Question: Express in one sentence what the figure is showing.
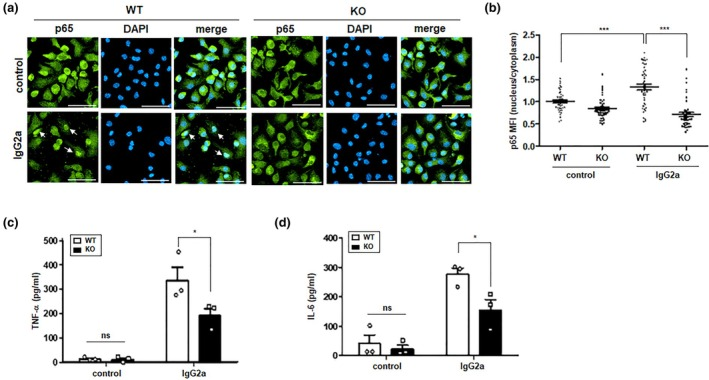
Answer: Impaired FcγR‐mediated NF‐κB nuclear translocation and cytokine production in ARAP‐KO BMDCs. (a, b) WT and KO BMDCs (2 × 10 5 ) either alone or with IgG2a and antimouse IgG antibody were added to the coverslips and incubated at 37°C for 1 h. For an immunofluorescence assay of NF‐κB (p65), cells were fixed, permeabilized, and stained with anti‐p65 followed by FITC‐conjugated secondary antibodies. Cells were scored as p65‐positive nuclei only when p65 signal colocalized with DAPI staining. (a) Representative images showing FcγR‐stimulated NF‐κB nuclear translocation (arrows) in the BMDCs of WT and KO mice. The experiment was repeated twice. Scale bars = 50 μm. (b) MFI of the nucleus/cytoplasm of each cell. The data are the averaged intensities of 40 cells blindly selected from four random microscopic fields for each sample. The data are presented as the mean ± s.e.m. Statistical significance was determined by one‐way ANOVA with Tukey's post hoc tests. Significant comparisons are annotated as *** P < 0.001. (c, d) BMDCs from WT and KO mice were cultured in a plate with either media alone (control) or coated with IgG2a at 37°C for 24 h. The levels of TNF‐α (c) and IL‐6 (d) in the supernatants were compared using ELISA. The data represent the mean ± s.e.m. of three independent experiments. Statistical significance was analyzed using two‐way ANOVA with Bonferroni's post hoc tests. Significant comparisons are noted as * P < 0.05; ns, no significance.